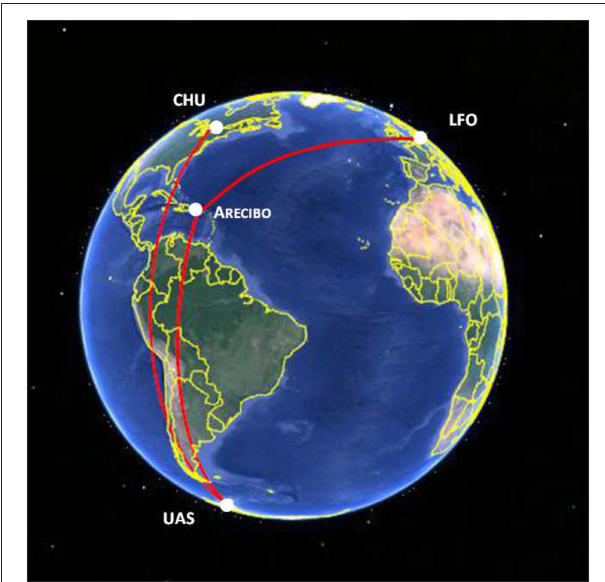
FIGURE 8 | Geometry of the long range radio paths: Arecibo–UAS (9,187km), as well as CHU (Ottawa, Canada–UAS (12,332km), and Arecibo–LFO (9,393km).